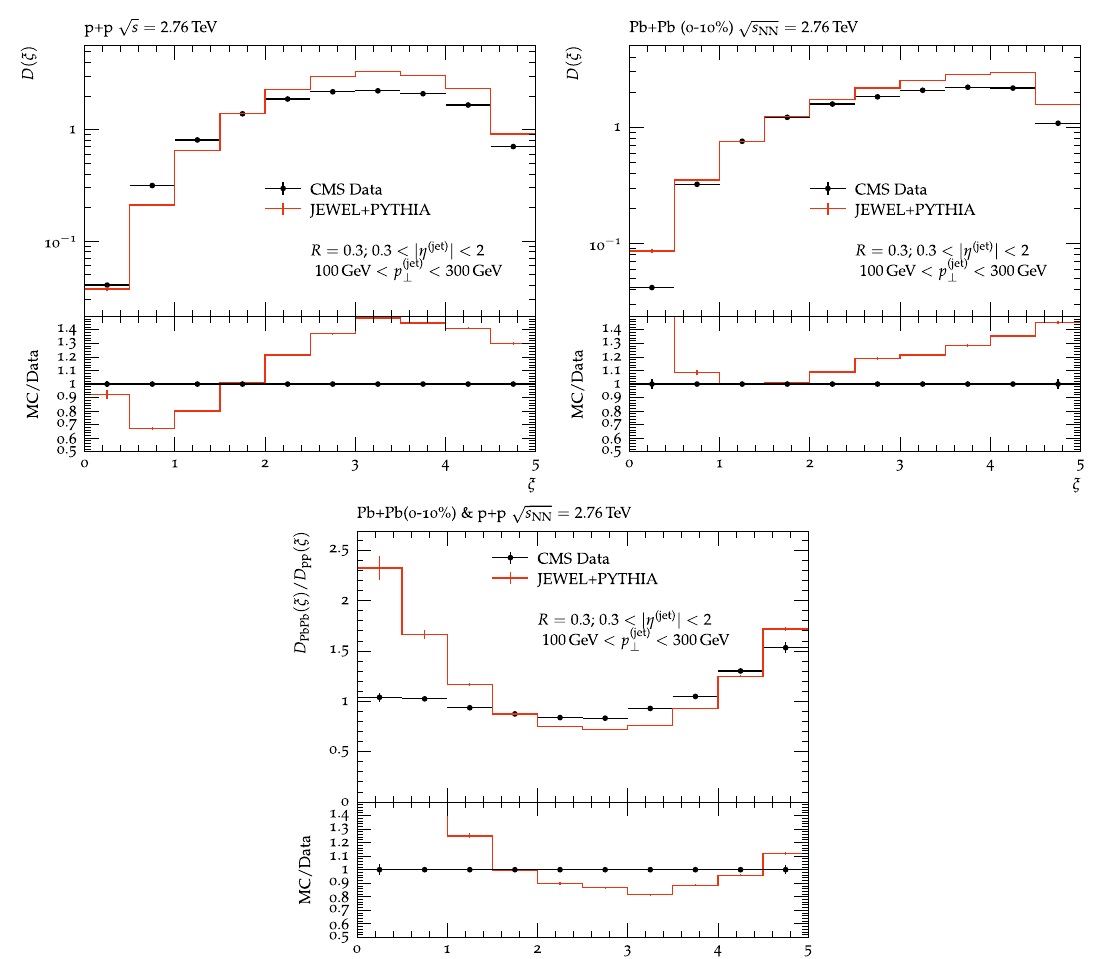
Fig. 11 Jet fragmentation function for charged particles with p ⊥ > 1 GeV as a function of ξ = ln ( 1 / z ) at CMS [83] for R = 0 . 3 anti- k ⊥ jets with 100 GeV < p